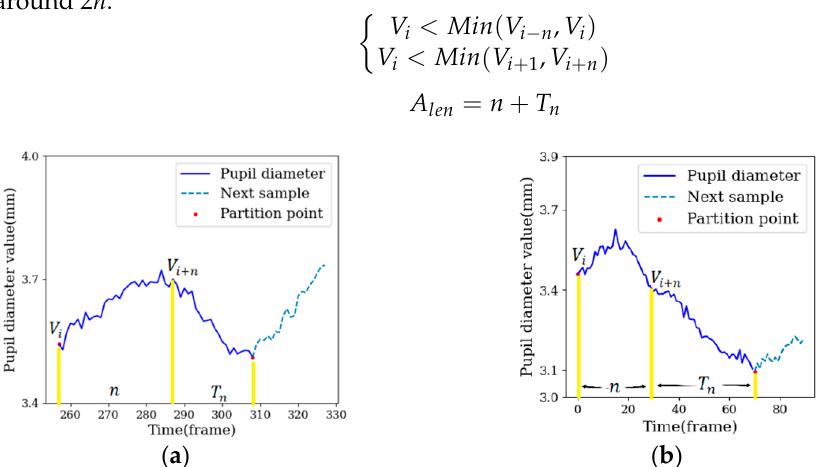
Figure 5. Schematic diagram of adaptive window length, where ( a ) shows T n less than n and ( b ) shows T n greater than n